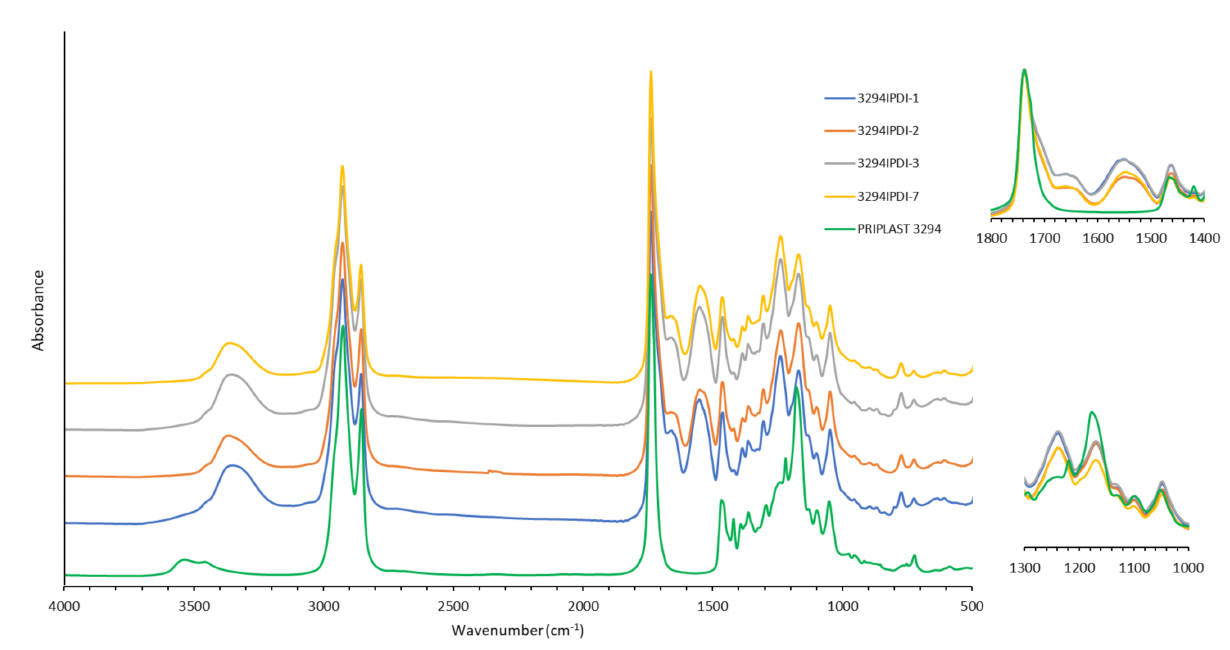
Figure 5. FTIR spectra in the MIR region for synthesized WPUD films. Magnifications of the 1800–1400 cm − 1 and 1300–1000 cm − 1 regions.